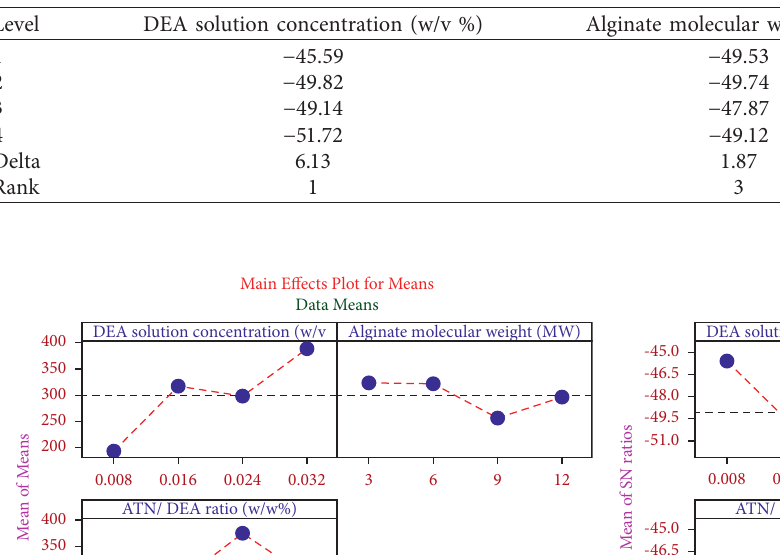
Table 4: Signal-to-noise ratio for particle size responses with respect to process parameters and their levels, the smaller the better.